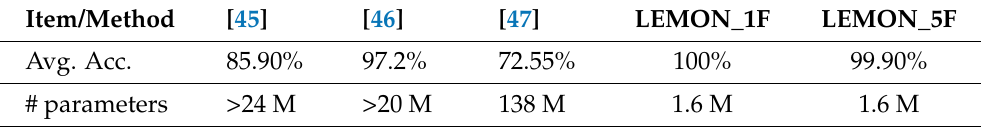
Table 10. Comparison of our approach, trained with one-fold and five-fold cross-validation, with respect to the state-of-the-art methods on the KDEF Dataset in terms of average accuracy and number of parameters.